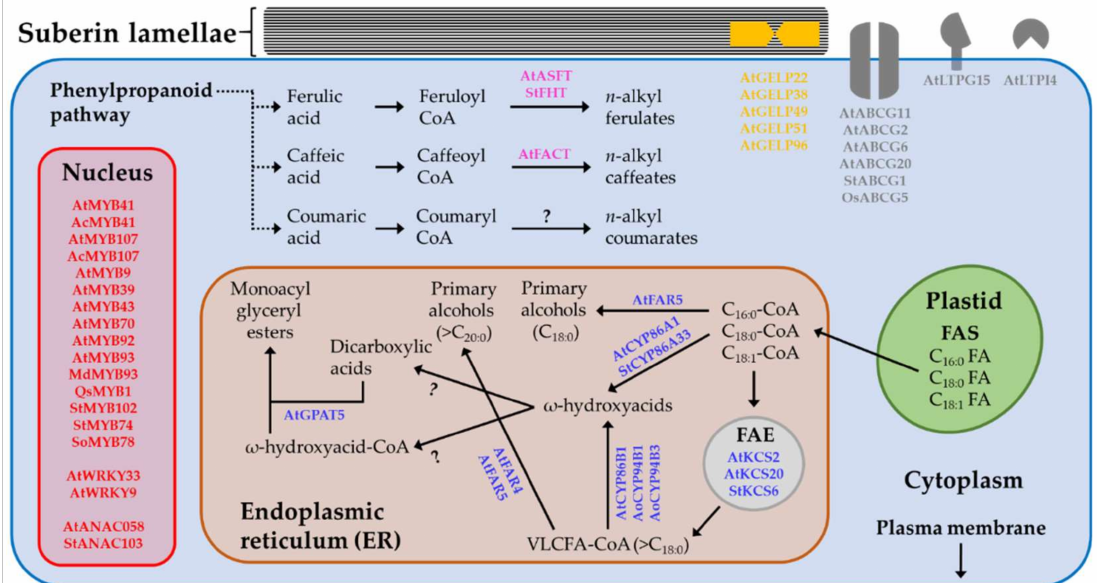
Figure 3. Schematic representation of the biosynthetic pathway of suberin in plants. The scheme is proposed based on previous evidence in the literature and shows all genes/enzymes listed in Table 1 according to their known enzymatic reactions. The scheme presents genes/enzymes in- volved in suberin polyaliphatic monomers (blue), suberin polyphenolic monomers (pink), suberin monomer polymerization (orange), suberin monomer transport (gray) and regulation of the suberin pathway (red). Dashed lines represent more than one enzymatic step, while question marks above enzymatic reactions indicate that genes/enzymes involved in these reactions are yet to be defined. Gene/enzyme abbreviations: ASFT, ALIPHATIC SUBERIN FERULOYL TRANSFERASE; CYP, CY- TOCHROME P450 (FATTY ACYL ω -HYDROXYLASE); FACT, FATTY ALCOHOL:CAFFEOYL-CoA CAFFEOYL TRANSFERASE; FAR, FATTY ACYL-CoA REDUCTASE; FHT, FATTY ALCOHOL HY- DROXYCINNAMOYL TRANSFERASE; GELP, GDSL-type ESTERASE/LIPASE PROTEINS; GPAT, GLYCEROL-3-PHOSPHATE ACYLTRANSFERASE; KCS, β -KETOACYL-CoA SYNTHETASE; LTP, LIPID TRANSFER PROTEIN; LTPG, GLYCOSYLPHOSPHATIDYLINOSITOL (GPI)-ANCHORED LIPID TRANSFER PROTEIN. Species abbreviations: Ac, Actinidia chinensis ; Ao, Avicennia officinalis ; At, Arabidopsis thaliana ; Md, Malus x domestica ; Os, Oryza sativa ; Qs, Quercus suber ; So, Saccharum offcinarum ; St, Solanum tuberosum